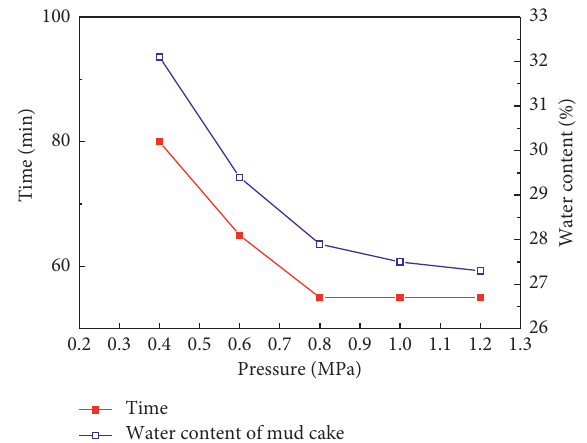
Figure 12: Effects of changing pressure on the time required for slurry filtration to reach stability and the final water content of the mud cake, after adding CPAM12.